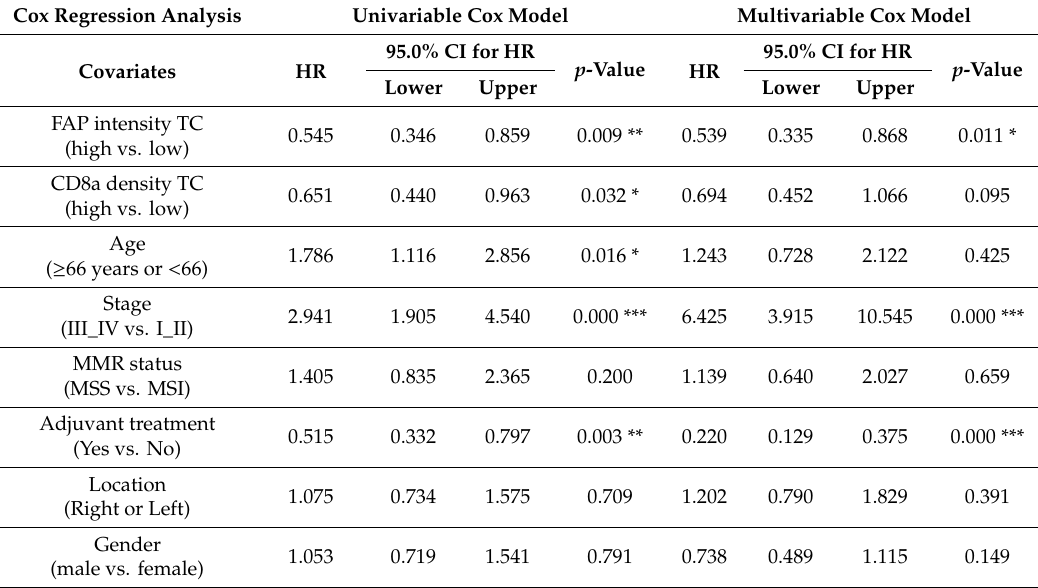
Figure 1. ( A ) Immunostaining of tissue microarray (TMA) cores showing low vs. high scores of FAP intensity of stromal cells in colon cancers. ( B ) Overall survival for FAP in the U-CAN cohort. Log-rank test ( p -value) showed that patients with high FAP intensity had longer overall survival (OS) as compared to patients with low FAP intensity. Table 1. Univariable and multivariable Cox models of FAP intensity and CD8a density predicting the overall survival of colon cancer patients in the U-CAN cohort.